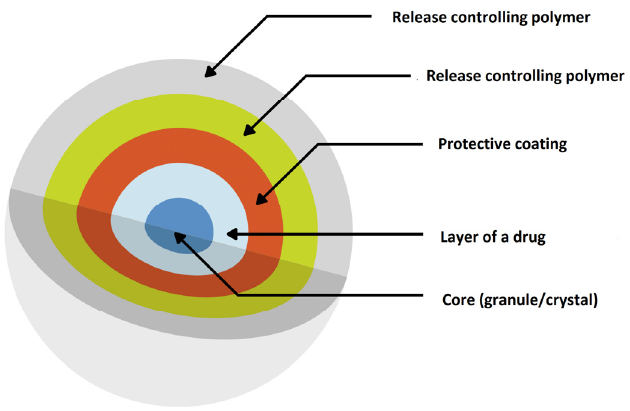
Figure 7. Scheme illustration of SODAS ® delivery system modified from Elan drug technologies [105].